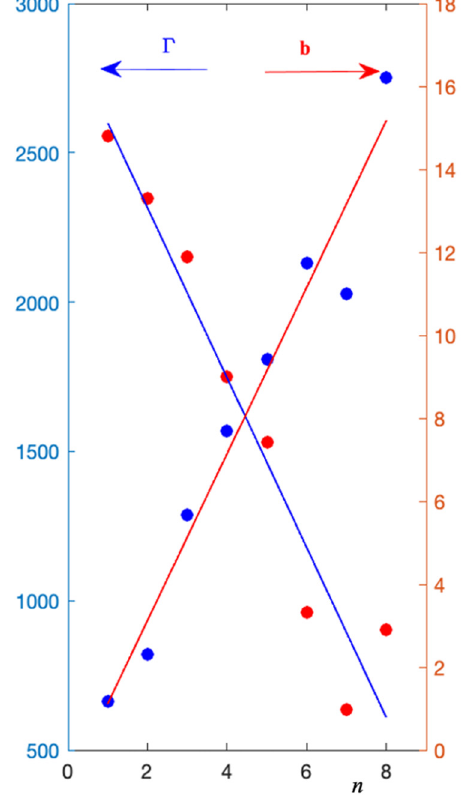
Figure 8. Characteristic parameters of fluorescence emission (Equation (28)) as a function of the number of carbon atoms.